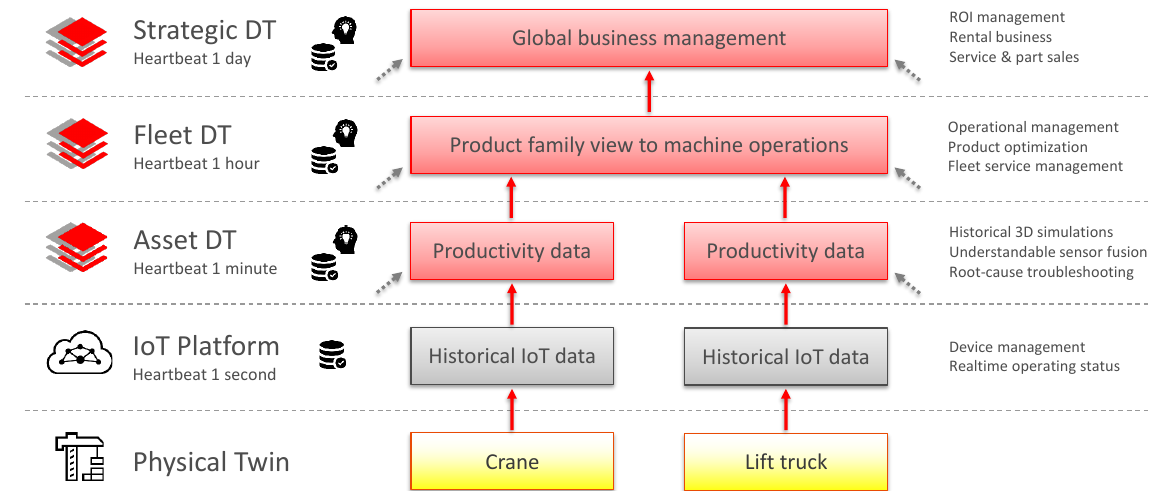
Figure 3. The layers of the DT core framework with update rate getting less frequent as data flows from physical twin to strategic decision-making level. Examples of use cases are given on the